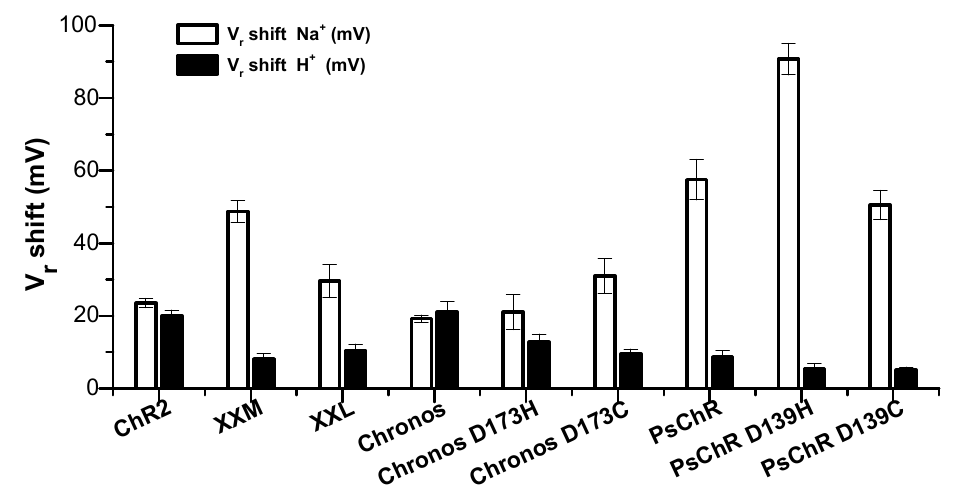
Figure 3. Comparison of Na + and H + permeabilities of ChR2, Chronos, Ps ChR, and their mutants.